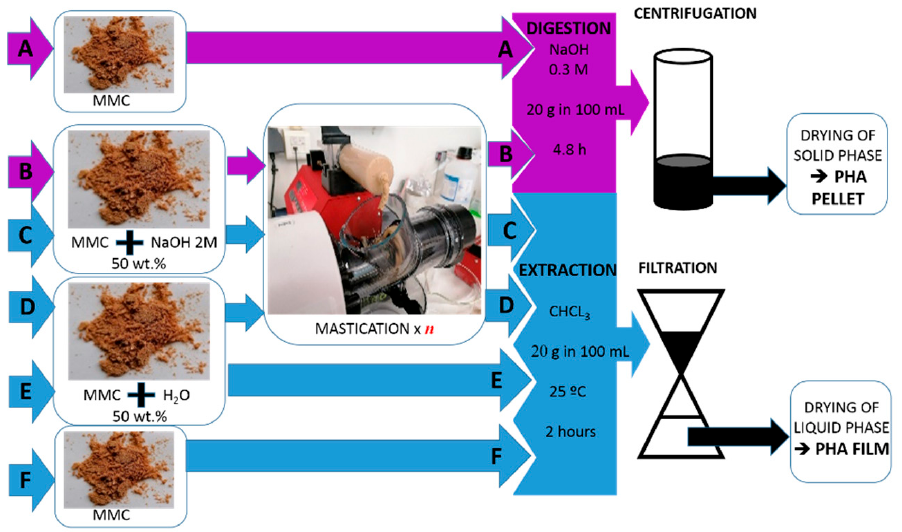
Figure 2. Flow chart of the downstreaming protocols used for digestion with 0.3 M NaOH or extraction with CHCl 3 . The dried biomass (MMC) containing 50 wt% PHA was processed using routes A to F, yielding eight samples in the form of pellets (digestion, samples A and B) or films (extraction, samples C to F). Samples C1 and D1 were masticated with n =1, whereas samples B, C5 and D5 were masticated with n =5.